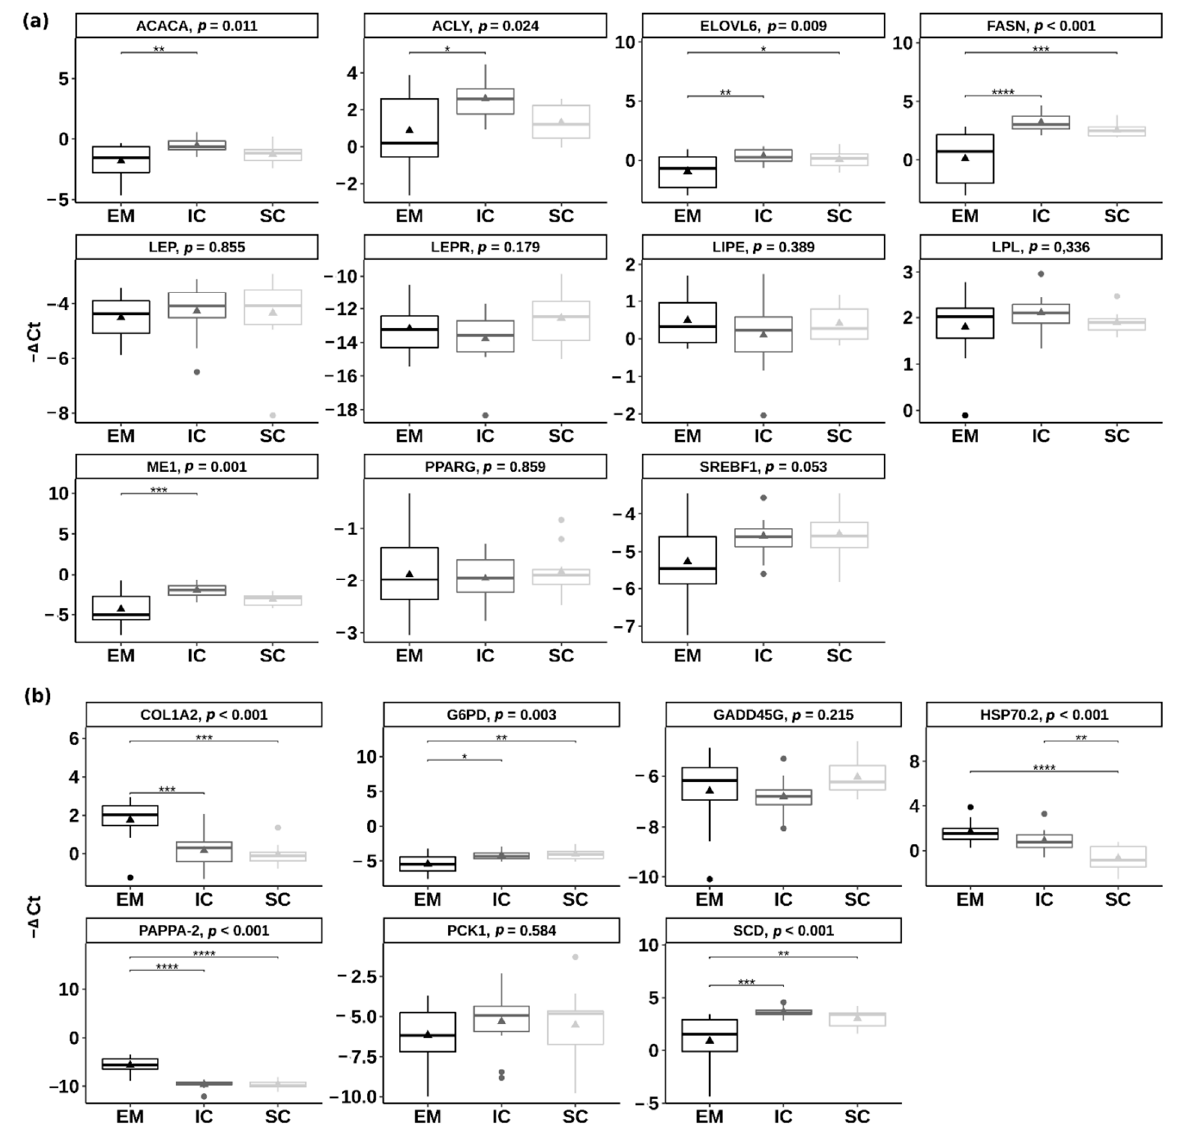
Figure 5. Differential expression of ( a ) the candidate genes involved in lipid metabolism and ( b ) the genes detected in the RNA-sequencing approach between entire males (EM), immunocastrated pigs (IC) and surgically castrated pigs (SC) in the inner backfat layer. The results are presenting ∆ Ct value of target transcripts derived using the comparative Ct method ( ∆ Ct = Ct geometric mean of controls − Ct target transcript ). Larger ∆ Ct represents higher gene expression. Triangles are representing the mean ∆ Ct value. In the case of statistical significance (reported as Tukey adjusted p -value), the asterisks are drawn (**** p < 0.0001, *** p < 0.001; ** p < 0.01; * p < 0.05). ACACA = acetyl CoA carboxylase; ACLY = ATP citrate lyase; COL1A2 = collagen type I alpha 2 chain; ELOVL6 = ELOVL fatty acid elongase 6; FASN = fatty acid syn- thetase; G6PD = glucose-6-phosphate dehydrogenase; GADD45G = growth arrest and DNA damage inducible gamma; HSP70.2 = heat shock protein family A member 1B; LEP = leptin; LEPR = leptin receptor; LIPE = lipase E; LPL = lipoprotein lipase; ME1 = malic enzyme 1; PAPPA-2 = pappalysin 2; PCK1 = phosphoenolpyruvate carboxykinase 1; PPAR γ = peroxi- some proliferator activated receptor gamma; SCD = stearoyl-CoA desaturase; SREBF1 = sterol regulatory element binding transcription factor